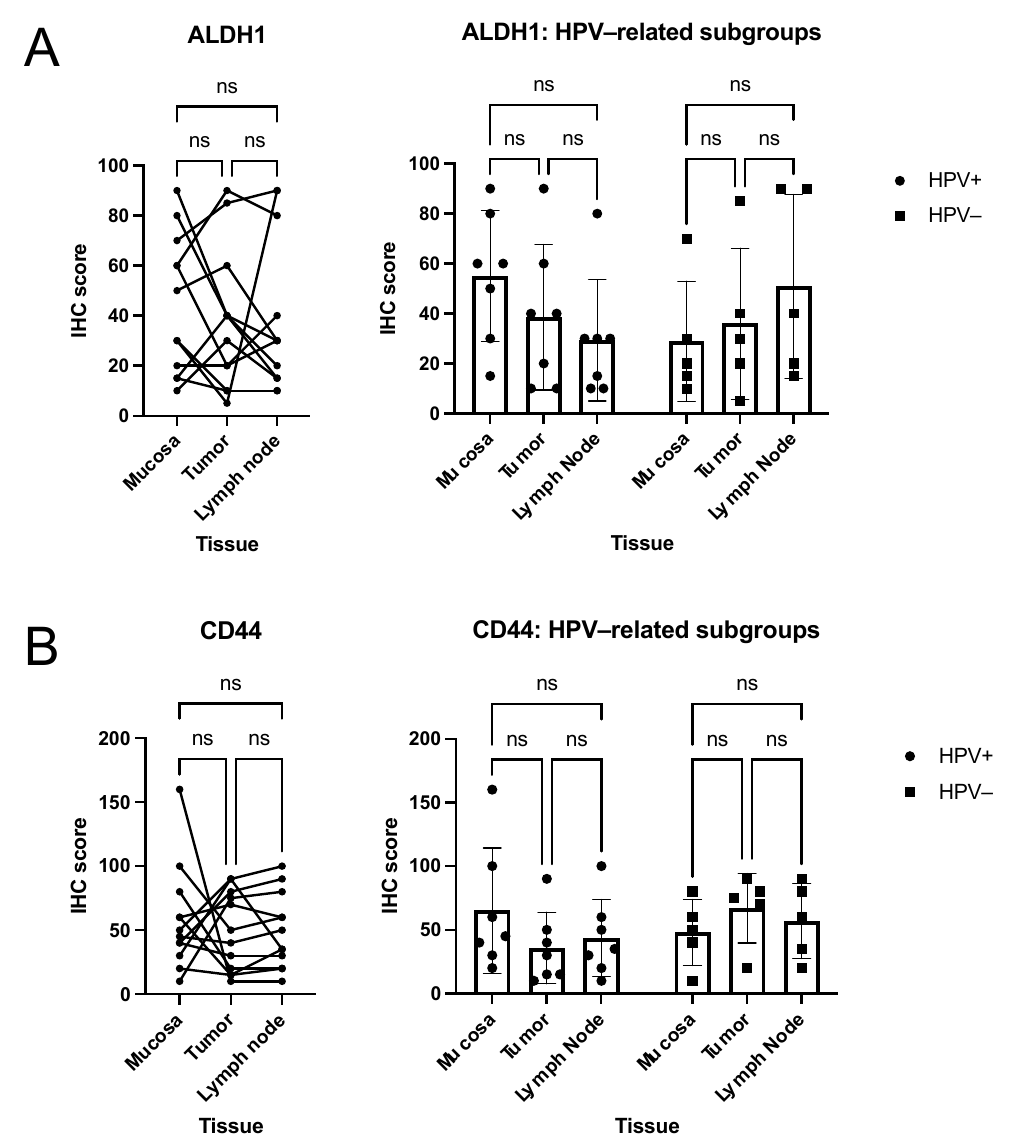
Figure 2. Quantitative analyses of ALDH1 ( A ) and CD44 ( B ) IHC scores in HNSCC. Connected dots deflect IHC scores of one individual patient in the exploratory analysis of HNSCC patients. Plots show means with SD of data stratified according to HPV-status (HPV-positive versus HPV-negative). p -values (one-way RM ANOVA for cohort analyses, two-way RM ANOVA for subcohort analyses) are indicated (n.s. p > 0.05): No significant differences were detected in the exploratory analyses of ALDH1 and CD44.